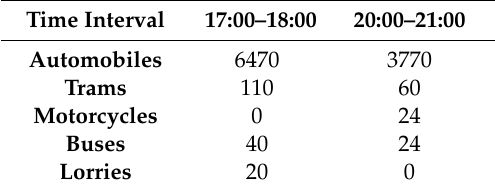
Table 3. Tra ffi c flow in the exposed area at di ff erent time intervals.